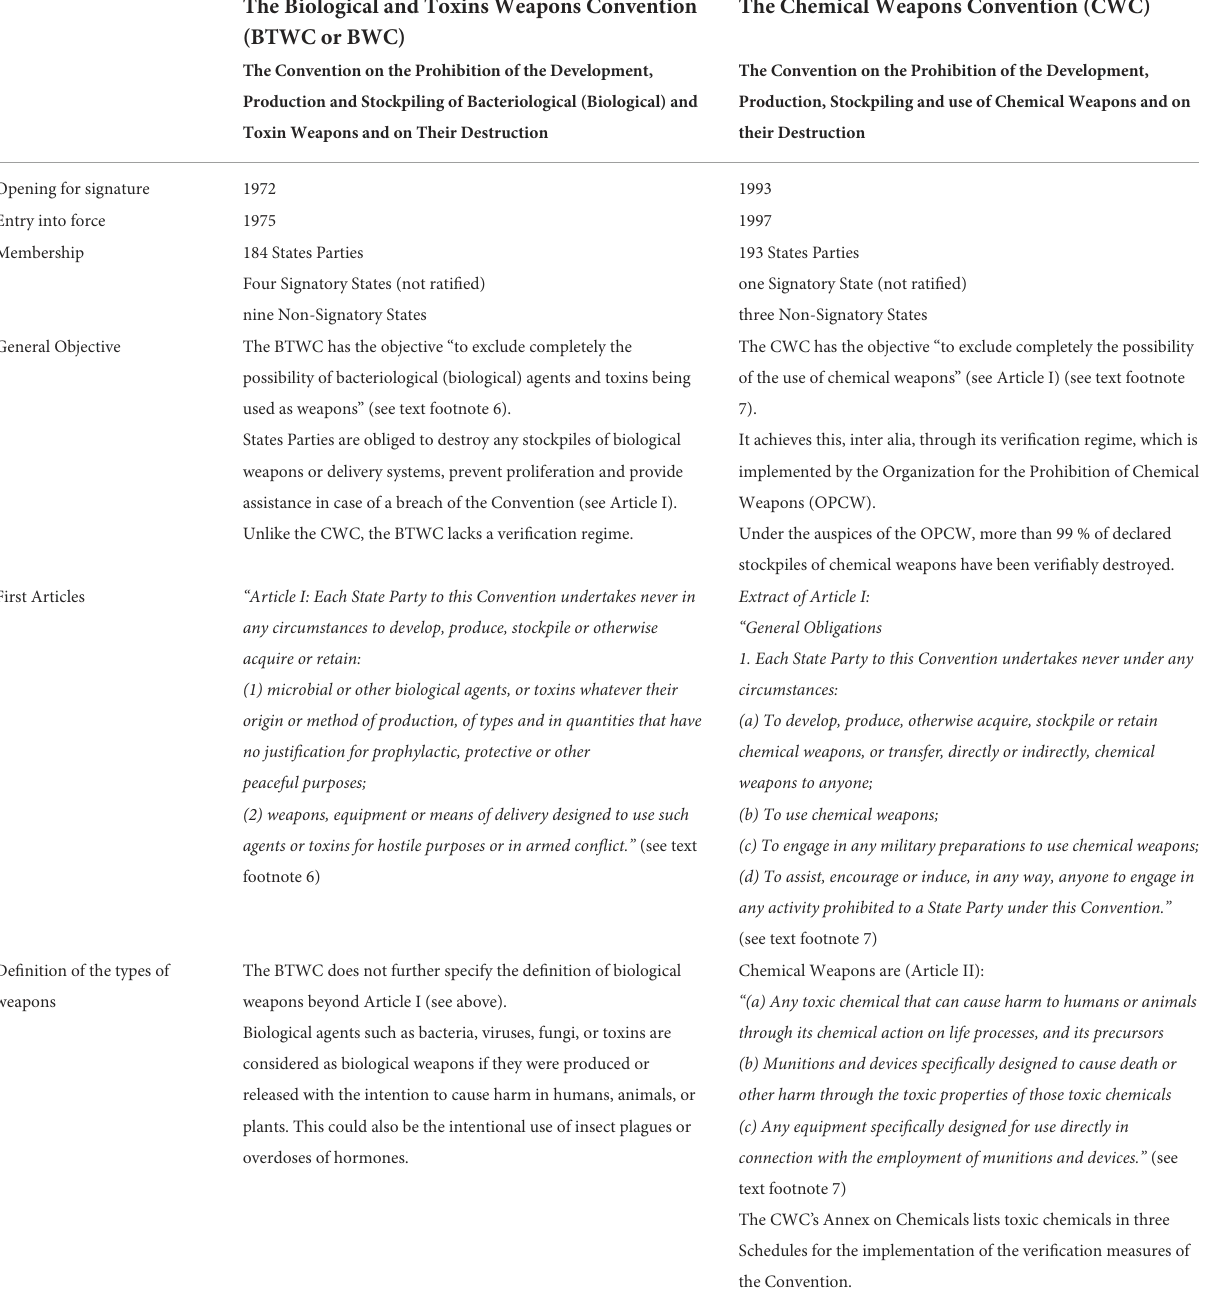
TABLE 1 The CWC and the BTWC ban entire categories of weapons of mass